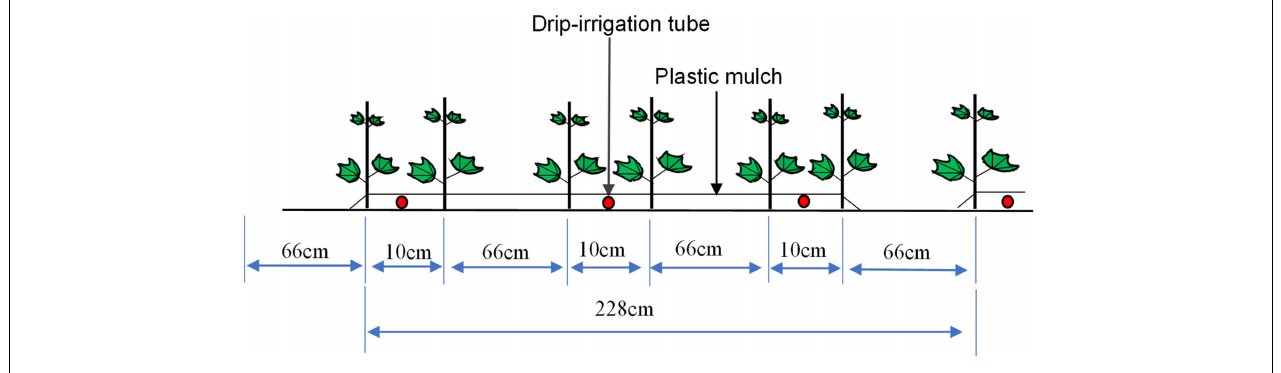
FIGURE 2 | Schematic diagram of the planting mode (one mulch and six rows of cotton